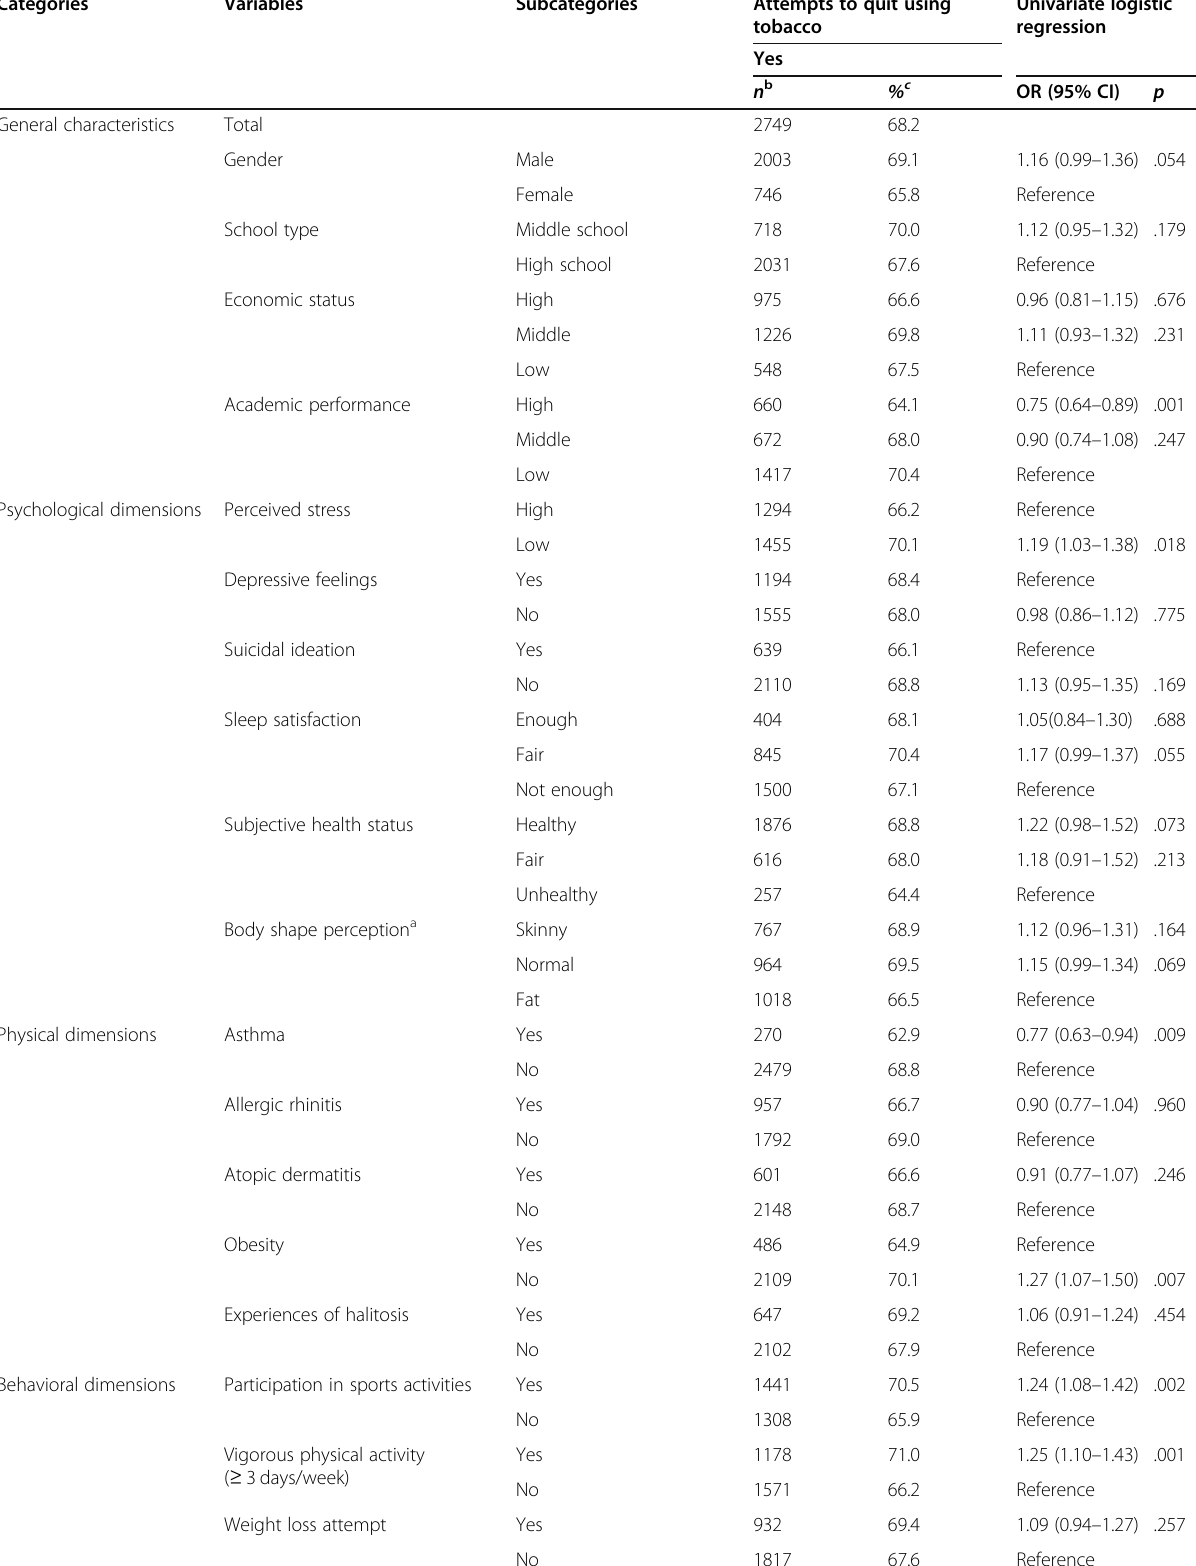
Table 2 Differences in attempts to quit using tobacco by related factors in adolescent tobacco users